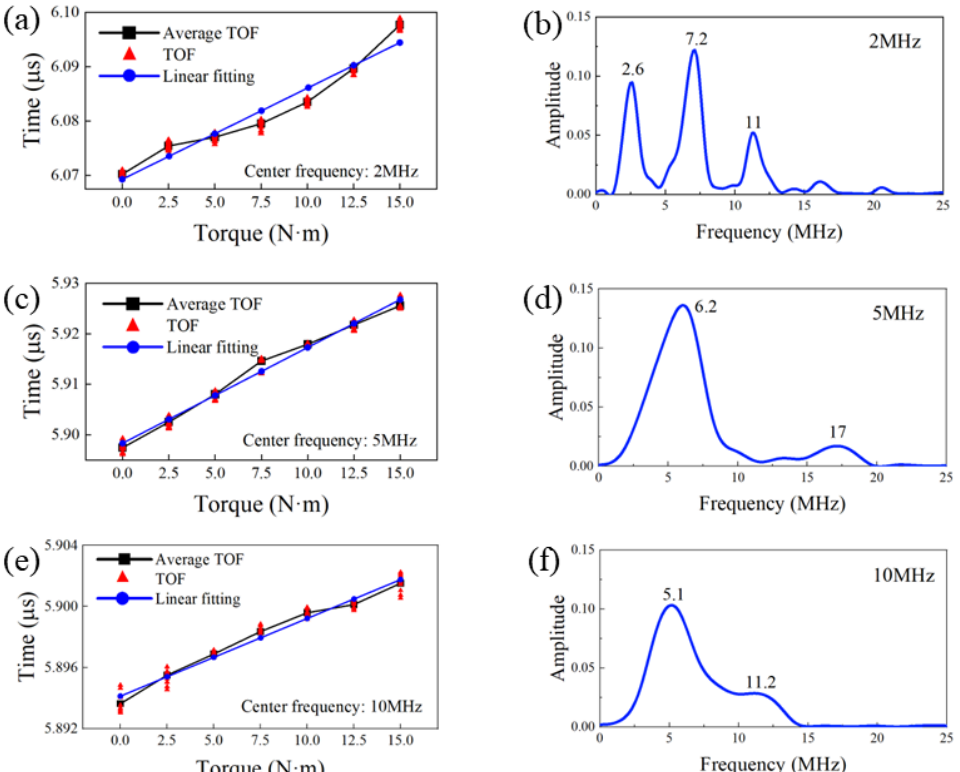
Figure 10. Relationship between the TOF and the preload torque for different center frequency sensors: ( a ) 2 MHz, ( c ) 5 MHz, ( e ) 10 MHz; spectrum of the first longitudinal wave signal for ( b ) 2 MHz, ( d ) 5 MHz, and ( f ) 10 MHz PZT sensors.